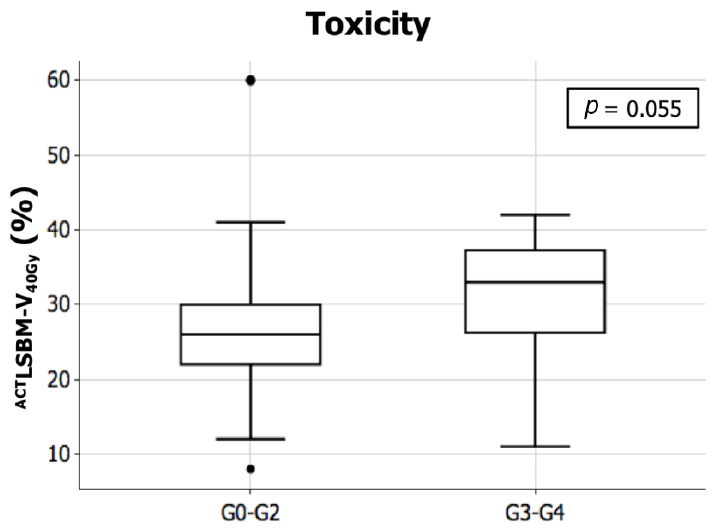
Figure 2. Mean values for the volume of active lumbar sacral bone marrow receiving 40 Gy (LSBM PET V 40 ) in patients experiencing major acute hematologic toxicity (G3–G4) compared to those who did not